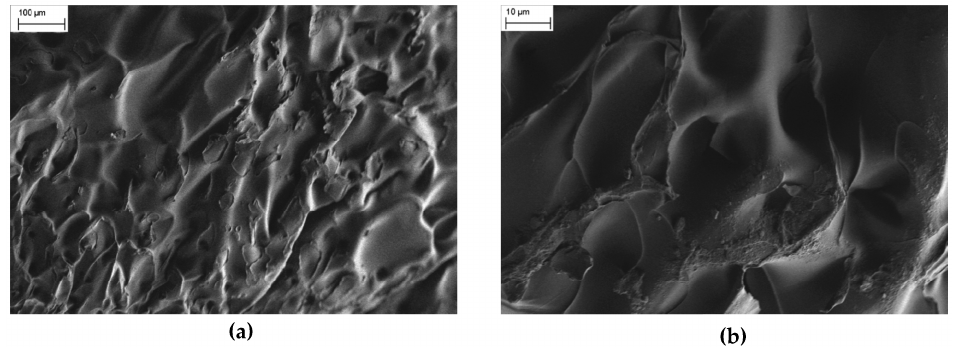
Figure 2. ( a ) Field emission scanning electron microscopy (FESEM) image collected for a pure PNIPAM hydrogels. ( b ) FESEM image collected for a pure PNIPAM hydrogel at a